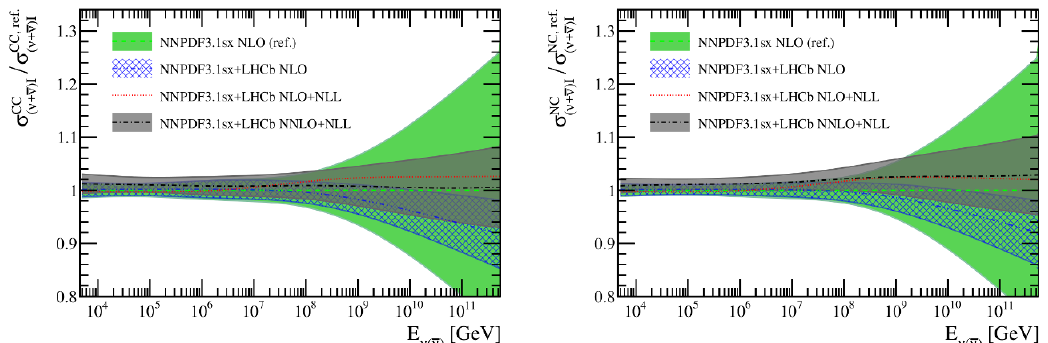
Figure 11 . The total CC (left) and NC (right plot) neutrino-isoscalar cross-section as a function of the energy E for di(cid:11)erent theoretical settings. Results are shown normalised to the central (cid:23) ((cid:22) (cid:23) ) value of the NNPDF3.1sx NLO calculation and averaged over neutrino- and antineutrino-induced processes. The uncertainty bands correspond to the 1 (cid:27) PDF